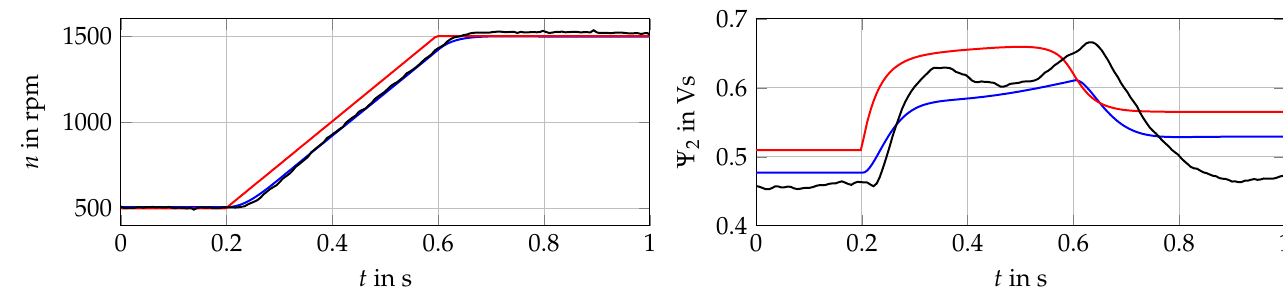
Figure 18. Measurements comparing fmincon based solution without anticipation to model predictive